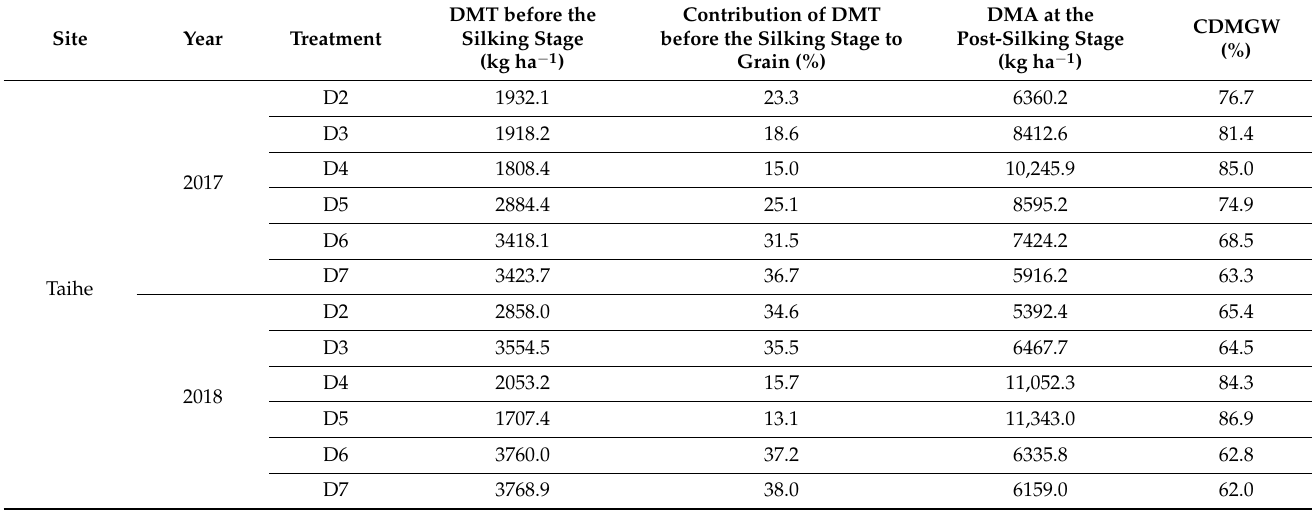
Figure 3. Aboveground DMA of different sites and planting densities. Note: Figure ( A , B ) represent DMA in Taihe. Figure ( C , D ) represent DMA in Hefei. Different letters above the bars indicate significant differences between different planting densities. Table 6. DMT from vegetative organs to grain and accumulation amount at the post-silking